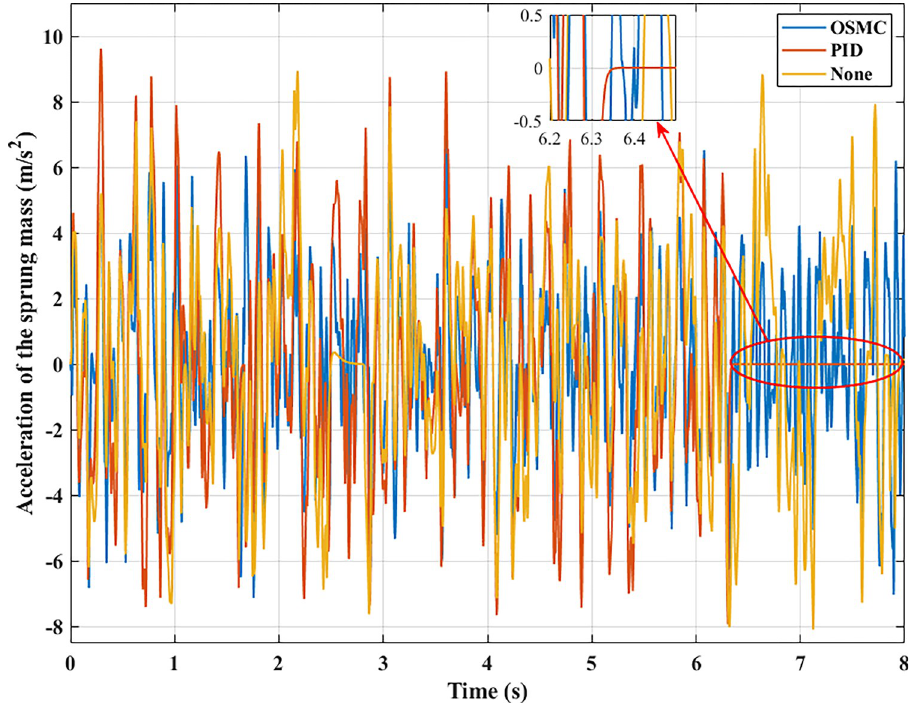
Fig 11. Acceleration of the sprung mass (case 3).